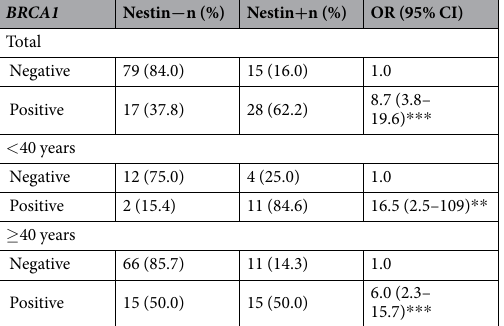
Table 1. Nestin protein expression and BRCA1 germline mutation status (Series III). n: number of patients; OR: odds ratio; CI: confidence interval; P-values by Pearson’s chi-square test, * < 0.05, ** < 0.01, *** < 0.001. BRCA2 germline mutated patients are excluded from the analysis. Missing data: Age: n = 3.